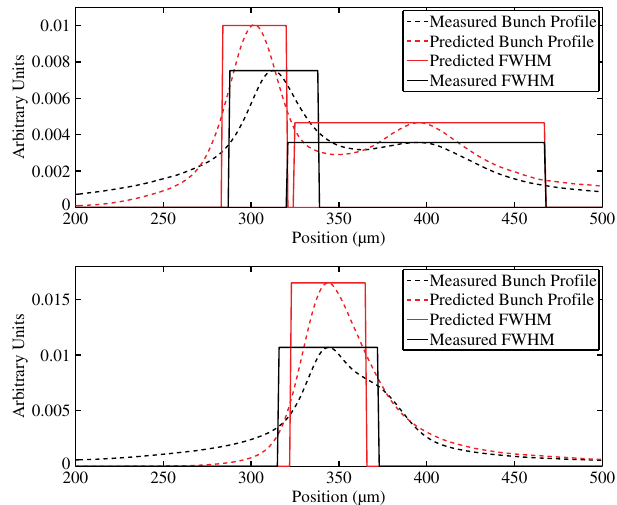
FIG. 8. Moving averages of the predicted and actual bunch profiles were used in order to estimate bunch width with a measurement of the full width half maximum.